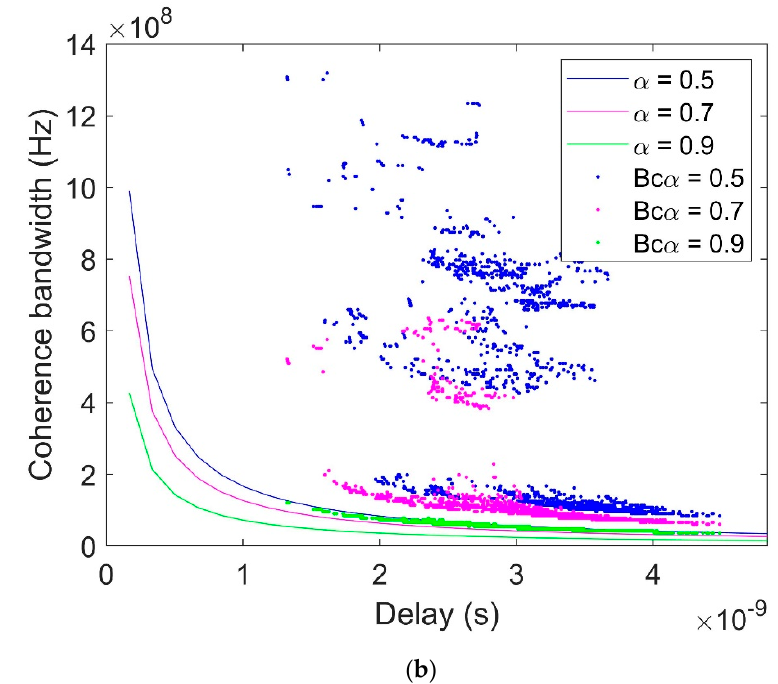
Figure 15. Theoretical Fleury’s limit and measured results, for different correlation levels α = 0.5, 0.7, or 0.9 at the corridor in the 40 GHz band: ( a ) LOS conditions, ( b ) OLOS conditions.